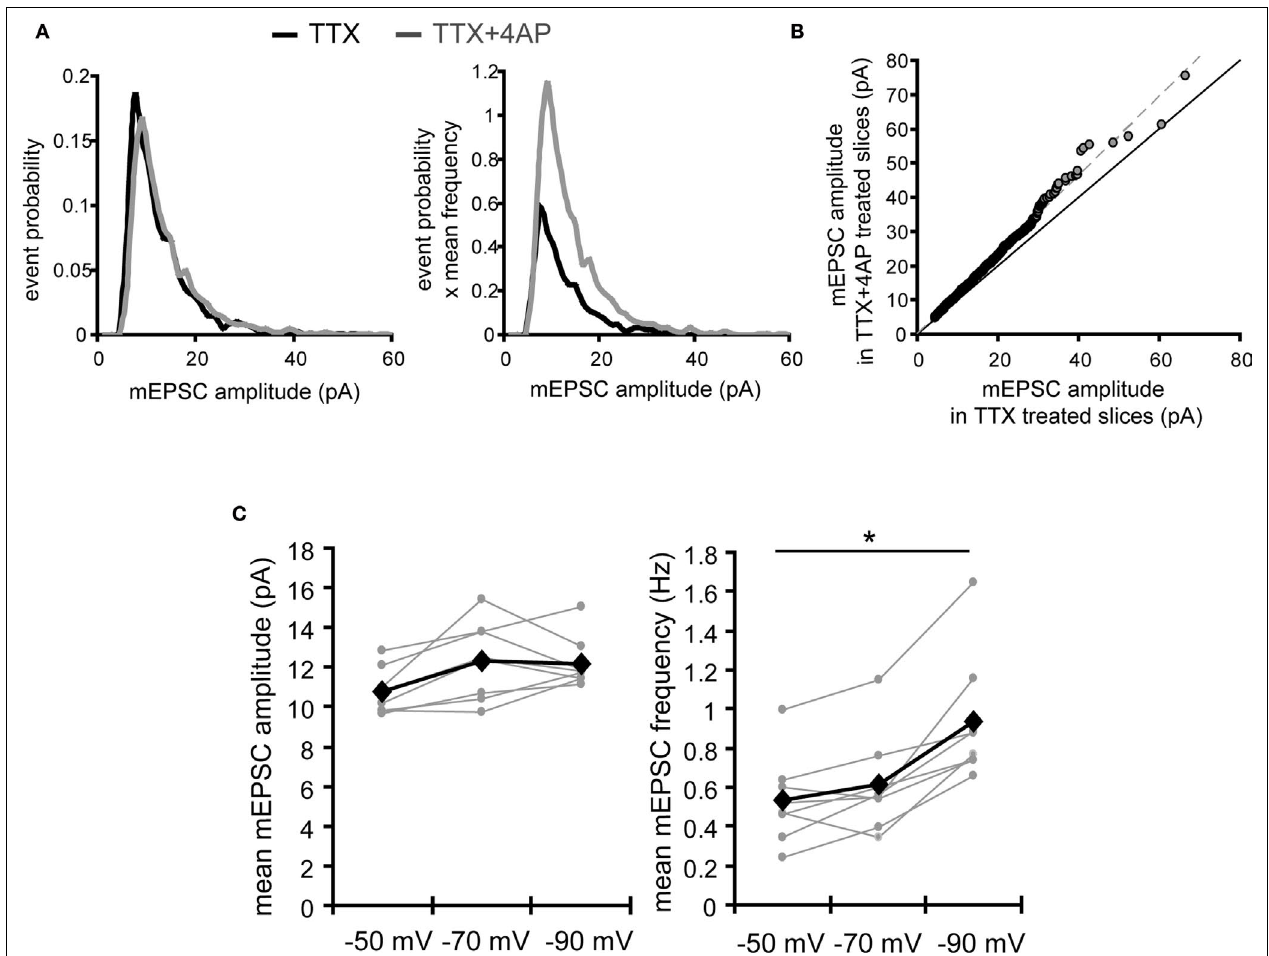
FIGURE 7 | A postsynaptic mechanism may contribute to the enhancement of mEPSC frequency by chronic A-type channel blockade. (A) Analysis of mEPSC amplitude recorded from the soma in either TTX or TTX + 4AP-treated slices. The left fi gure shows the event probability of the mEPSC amplitude. In the right fi gure, the mean mEPSC frequency was multiplied by the event probability, thus the resulting traces are equivalent to the event histogram. Note that most events are of small amplitude, indicating that the detection threshold for mEPSC analysis can infl uence the recorded frequency of events under our experimental conditions ( n = 2,080 mEPSCs chosen randomly from recording data used in Figure 1A ). (B) Ranked mEPSC amplitudes from TTX-treated slices were plotted against ranked mEPSC amplitudes from TTX + 4AP-treated slices.